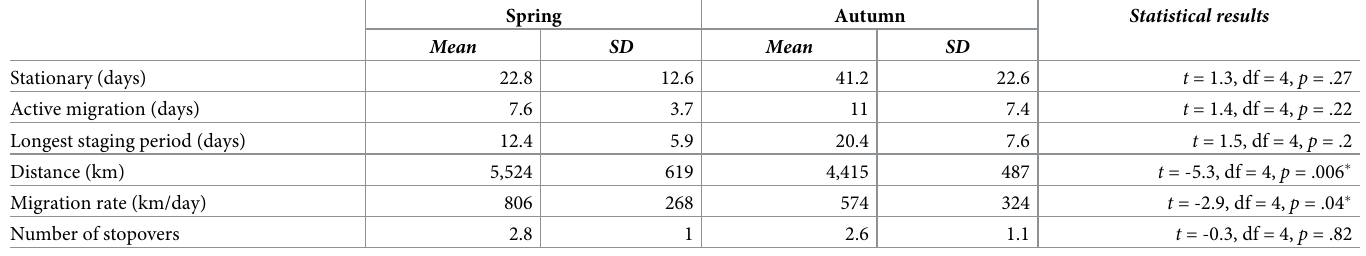
Table 1. Spring and autumn migration details. Results from paired t -tests. All data from individual 094 was excluded. The time spent fattening at APLORI and breeding grounds during spring and autumn migration, respectively, are not considered in estimates.